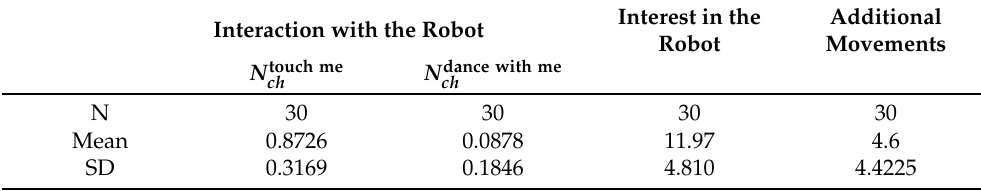
Table A3. Cumulative statistics. Autism.